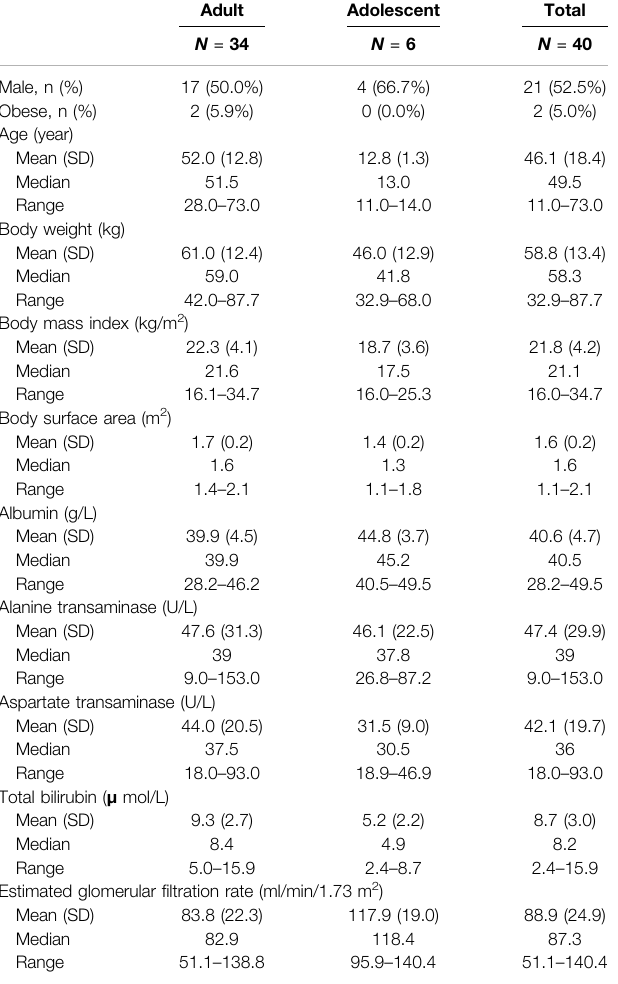
TABLE 2 | Descriptive statistics of baseline categorical and continuous covariates for subjects included in the PK analysis.